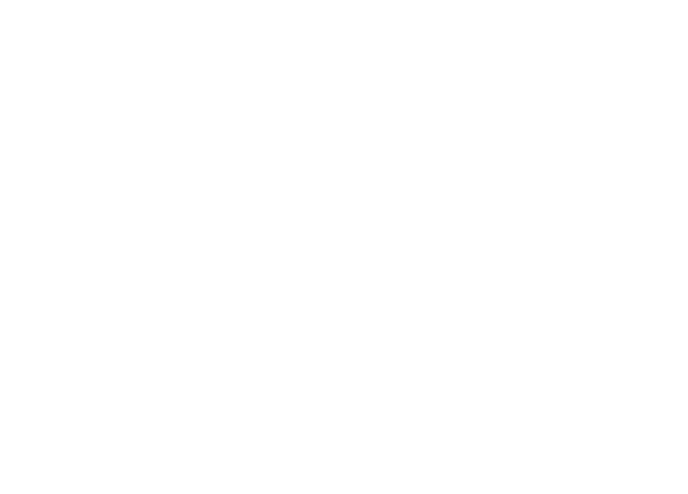
Figure 2. The internal structure of packaged piezoelectric ceramics. 1. Drive power line; 2. Fixed sea; 3. Package shell; 4. Laminated piezoelectric ceramics; 5. Disk spring; 6. Output shaft; 7. Linear bearing; 8. Locking cover.